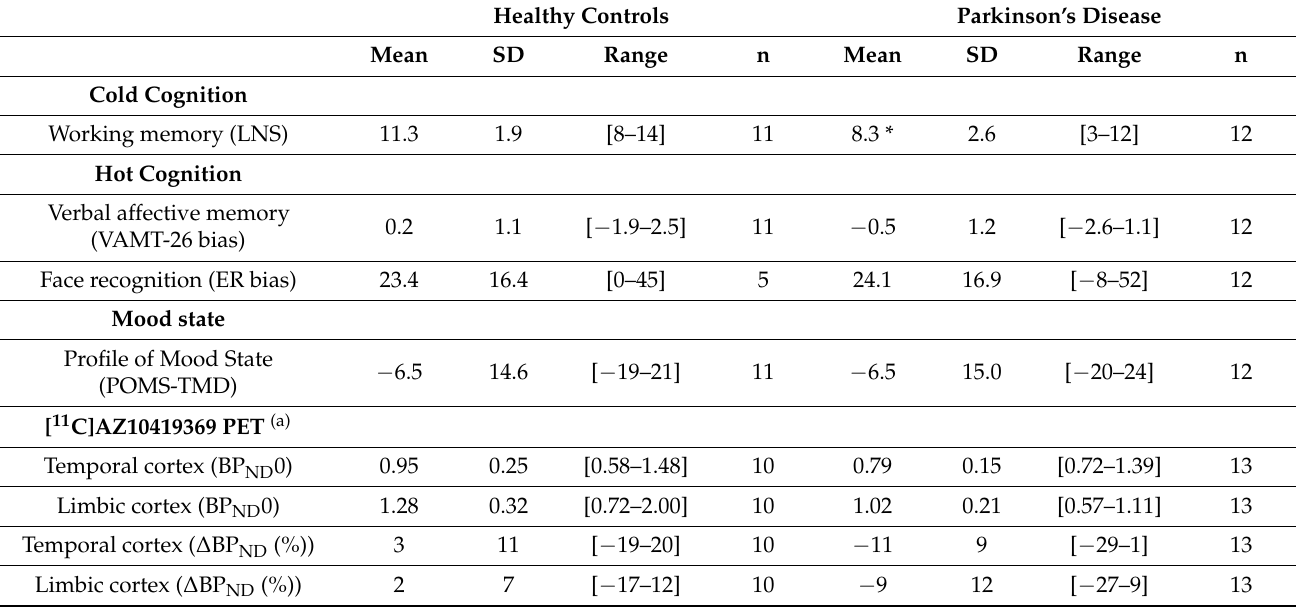
Table 1. Descriptive information of cognition, mood and 5-HT1BR